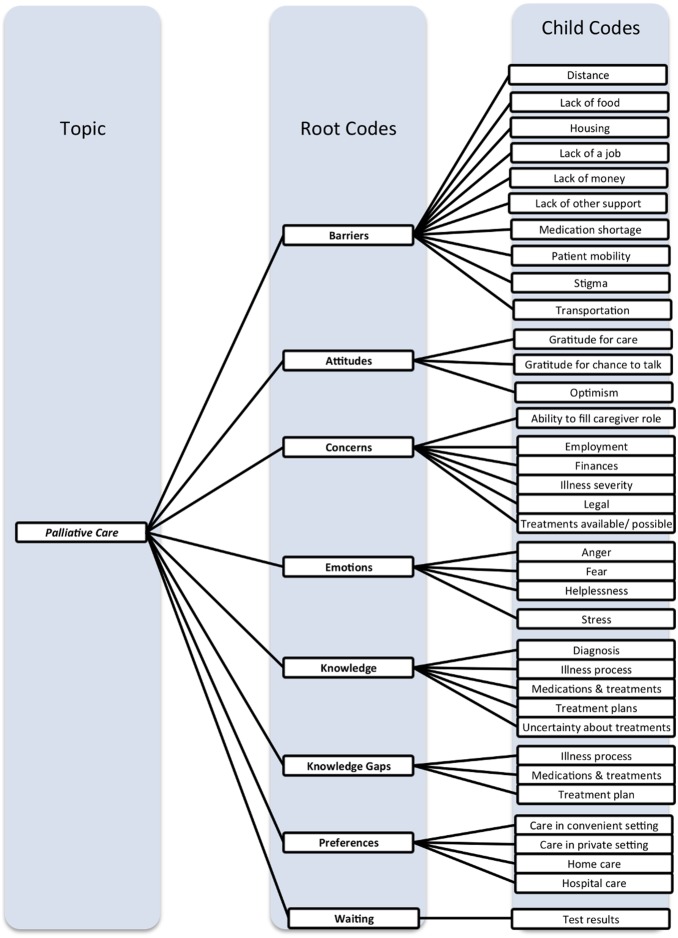
Major thematic codes generated from patient and caregiver interviews.The coding tree depicts major themes identified from structured patient and caregiver interviews. Codes relate to patient and family caregivers’ experiences with illness, palliative care services provided, and palliative care services desired. Subordinate child codes elaborate descriptions for each root code. All root and child codes were generated using content analysis methodology and Dedoose software (SocioCultural Research Consultants, LLC., Manhattan Beach, CA, USA).